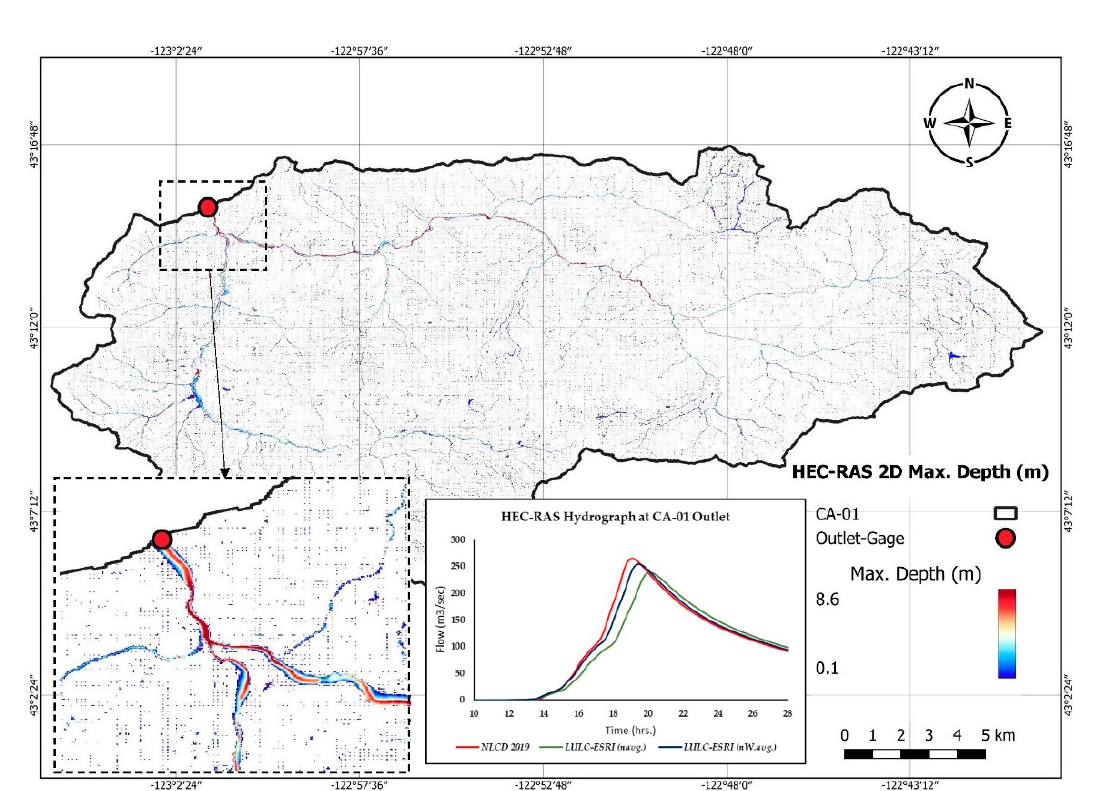
Figure 11. HEC-RAS calibration outputs : flow hydrographs at catchment outlet and maximum depths over the catchment area for CA-01.